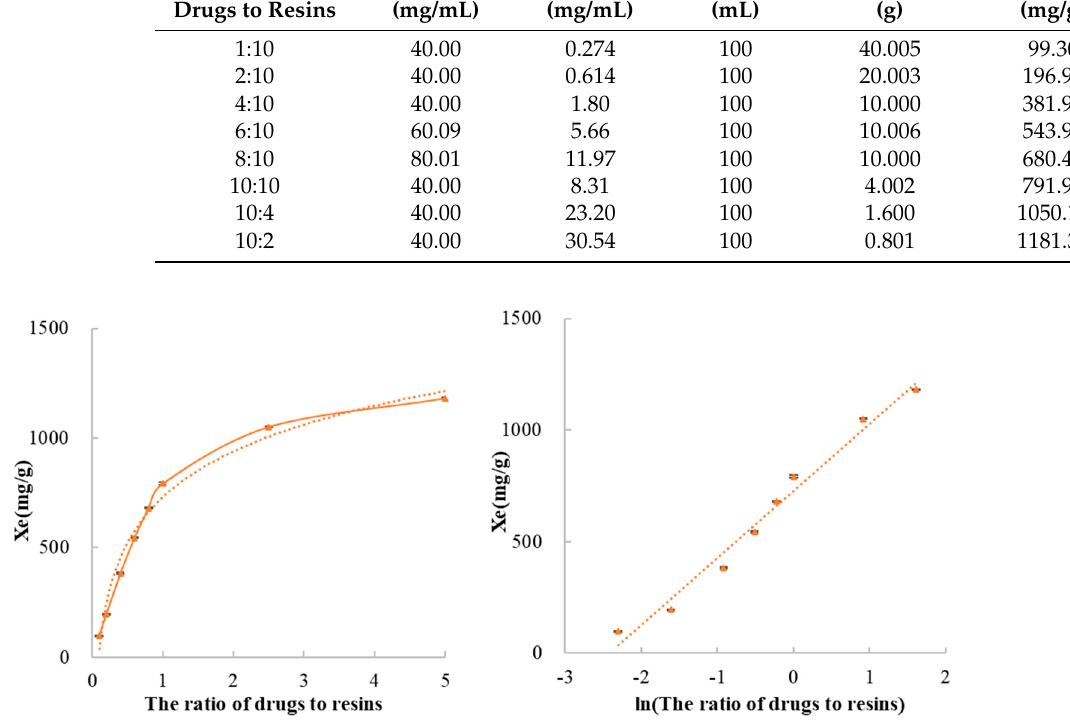
Figure 12. The effect of the ratio of drugs to resins on the exchange capacity at equilibrium. Table 2. Methylphenidate hydrochloride concentration in the drug–resin complex systems. The Ratio of Drugs to